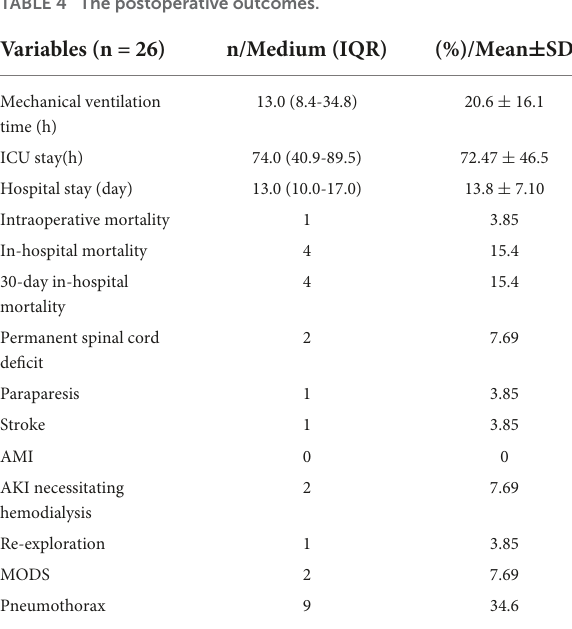
TABLE 4 The postoperative outcomes.